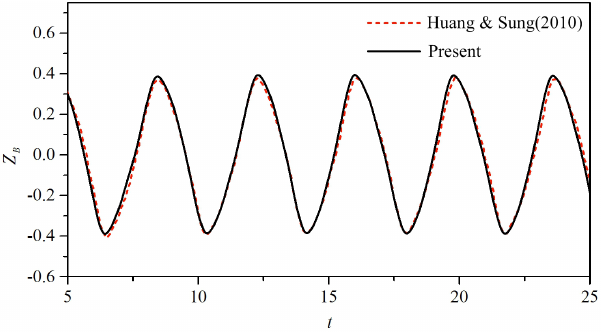
Figure 2. Comparison of the present result with previous data reported by Huang and Sung